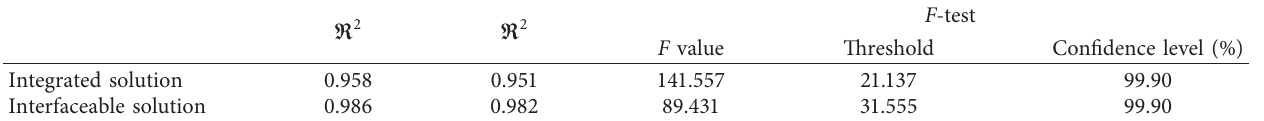
Table 4: Global statistical tests related to function f � f ( v ) in the case of network configuration 2. R 2